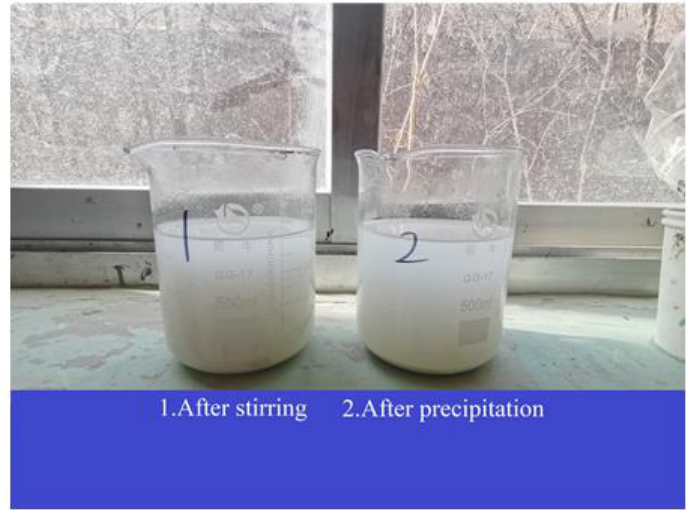
Figure 1. Preparation process of diatomite.